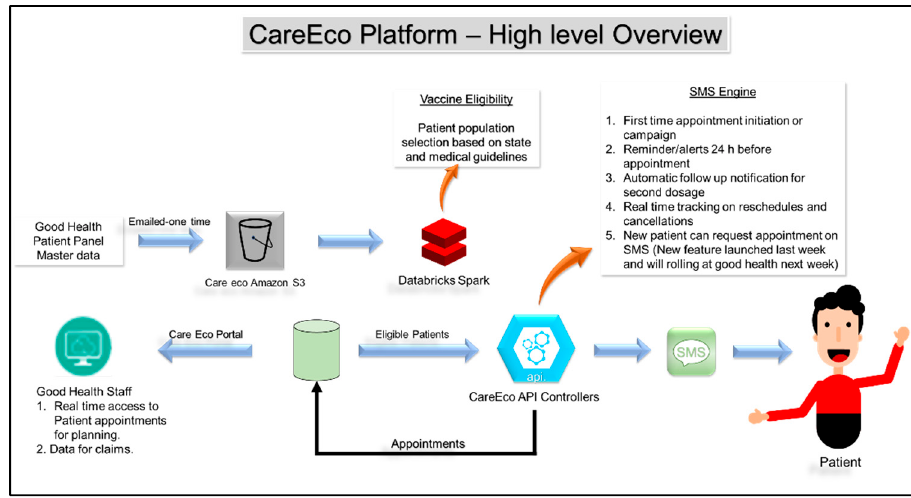
Figure 2. The flow of information for the Good Health Clinic using the scheduling app.